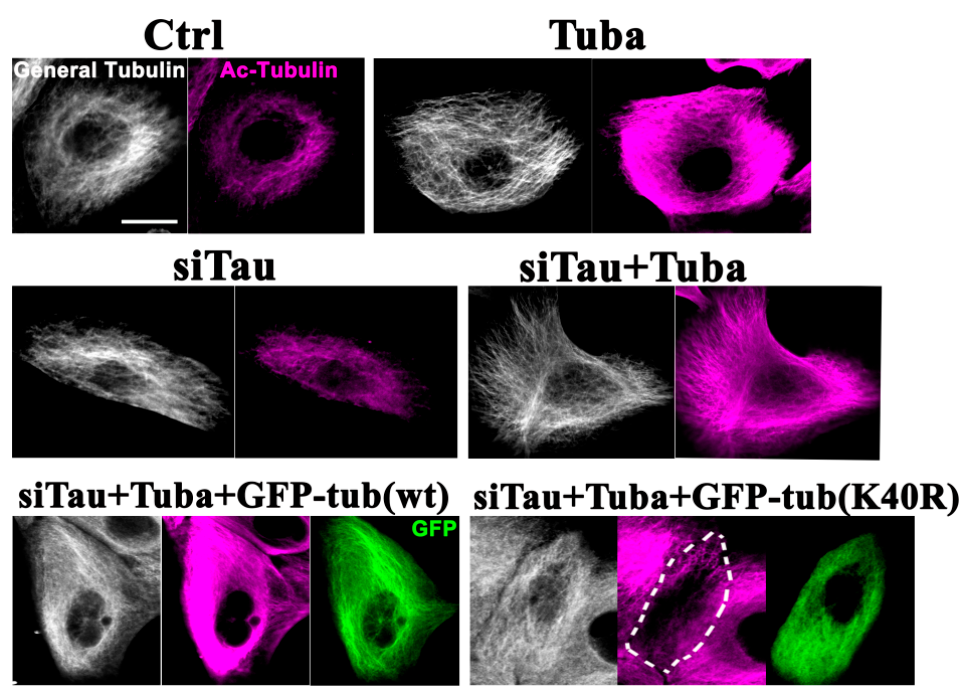
Figure 3. Effects of tubacin treatment and tubulin mutant overexpression on cellular microtubule acetylation in HMECs. HMECs were treated with tubacin and/or anti-tau siRNA with/without transfection of GFP-tagged wild-type α -tubulin or GFP-tagged mutant tubulin (K40R) expression plasmids. The cells were then cultured and stained with anti-tubulin or anti-acetylated tubulin antibodies. White signals denote general tubulin staining (General Tubulin), magenta signals indicate acetylated tubulin (Ac-Tubulin), and green signals indicate GFP. Tubacin-treated cells (Tuba) showed enhanced microtubule acetylation compared with the control cells (Ctrl). Tubacin treatment efficiently upregulated microtubule acetylation under siRNA knockdown of Tau (siTau + Tuba). The microtubule arrays of tubacin-treated cells or anti-tau siRNA-treated cells show no prominent organizational changes compared with the controls. Upon tau knockdown by siRNA, expression of a wild-type tubulin construct did not disrupt the tubacin-mediated enhancement of microtubule acetylation (siTau + Tuba + GFP-tub(wt)) whereas acetylation mutant tubulin expression lowered it to near normal levels (siTau + Tuba + GFP-tub(K40R)). The dotted area denotes a mutant tubulin-expressing cell. Scale bar, 10 µm.